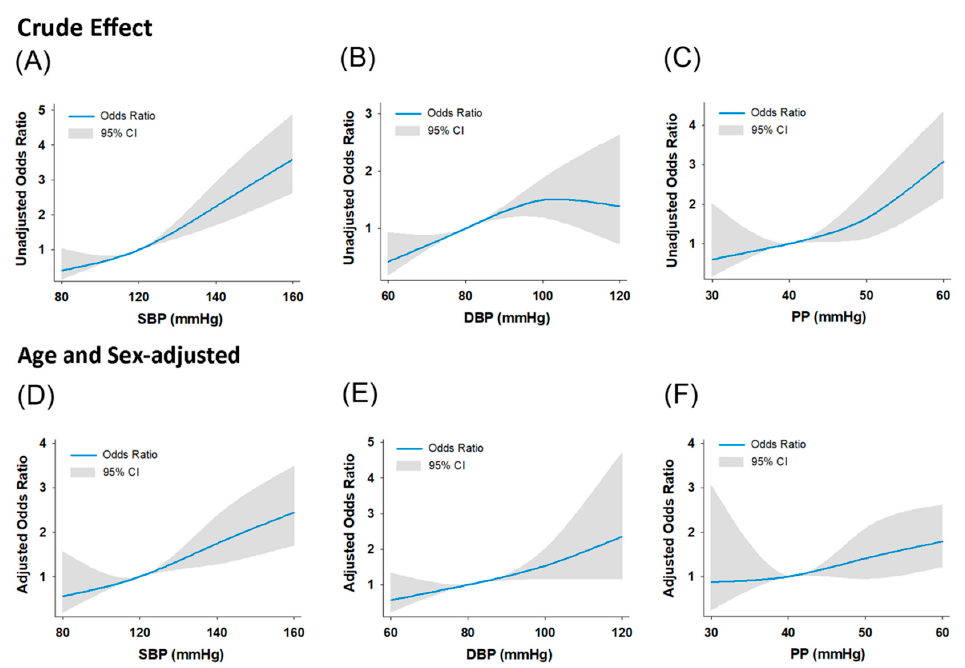
Figure 3. Probability of the presence of TAC predicted by the systolic blood pressure (SBP), dias- tolic blood pressure (DBP), and pulse pressure (PP), in subjects without known CVD or ongoing use of HTN medications ( n = 2784) ( A – C ), as well as after age and sex adjustment ( D – F